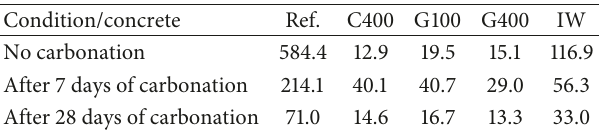
Table 3: Coefficient of capillary absorption ( A (g/m 2 h 0.5 )) by linear fitting of the results in Figure